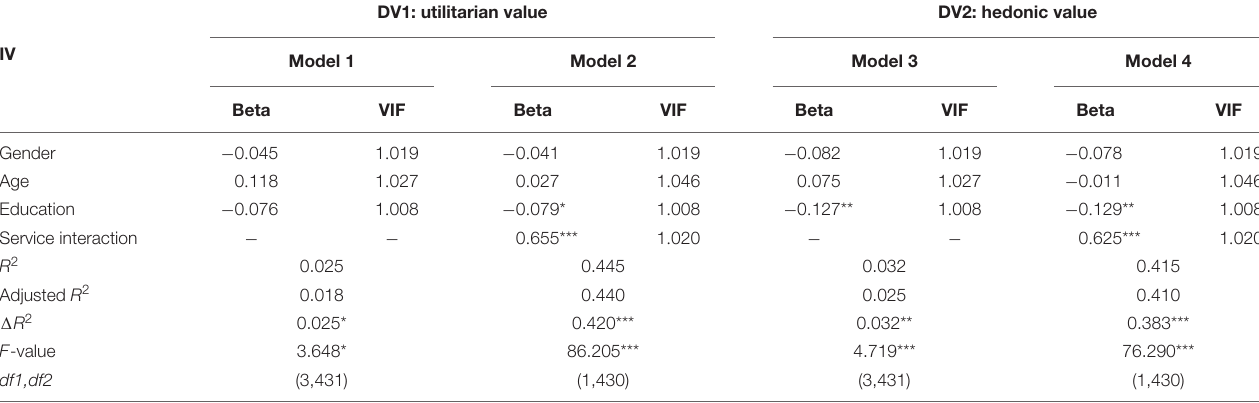
TABLE 4 | Main effect test.